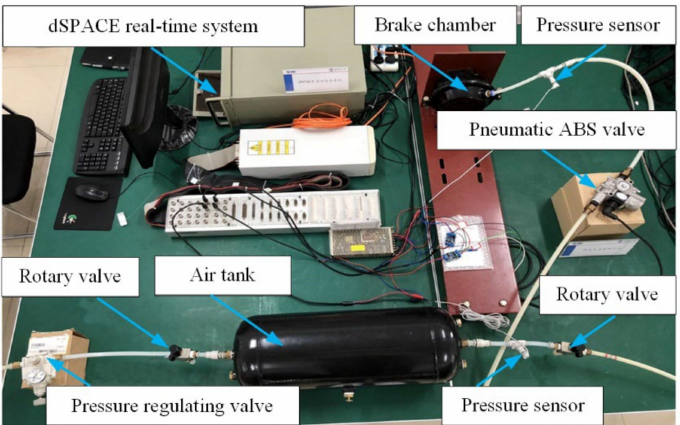
Figure 5. Test bench for braking pressure.